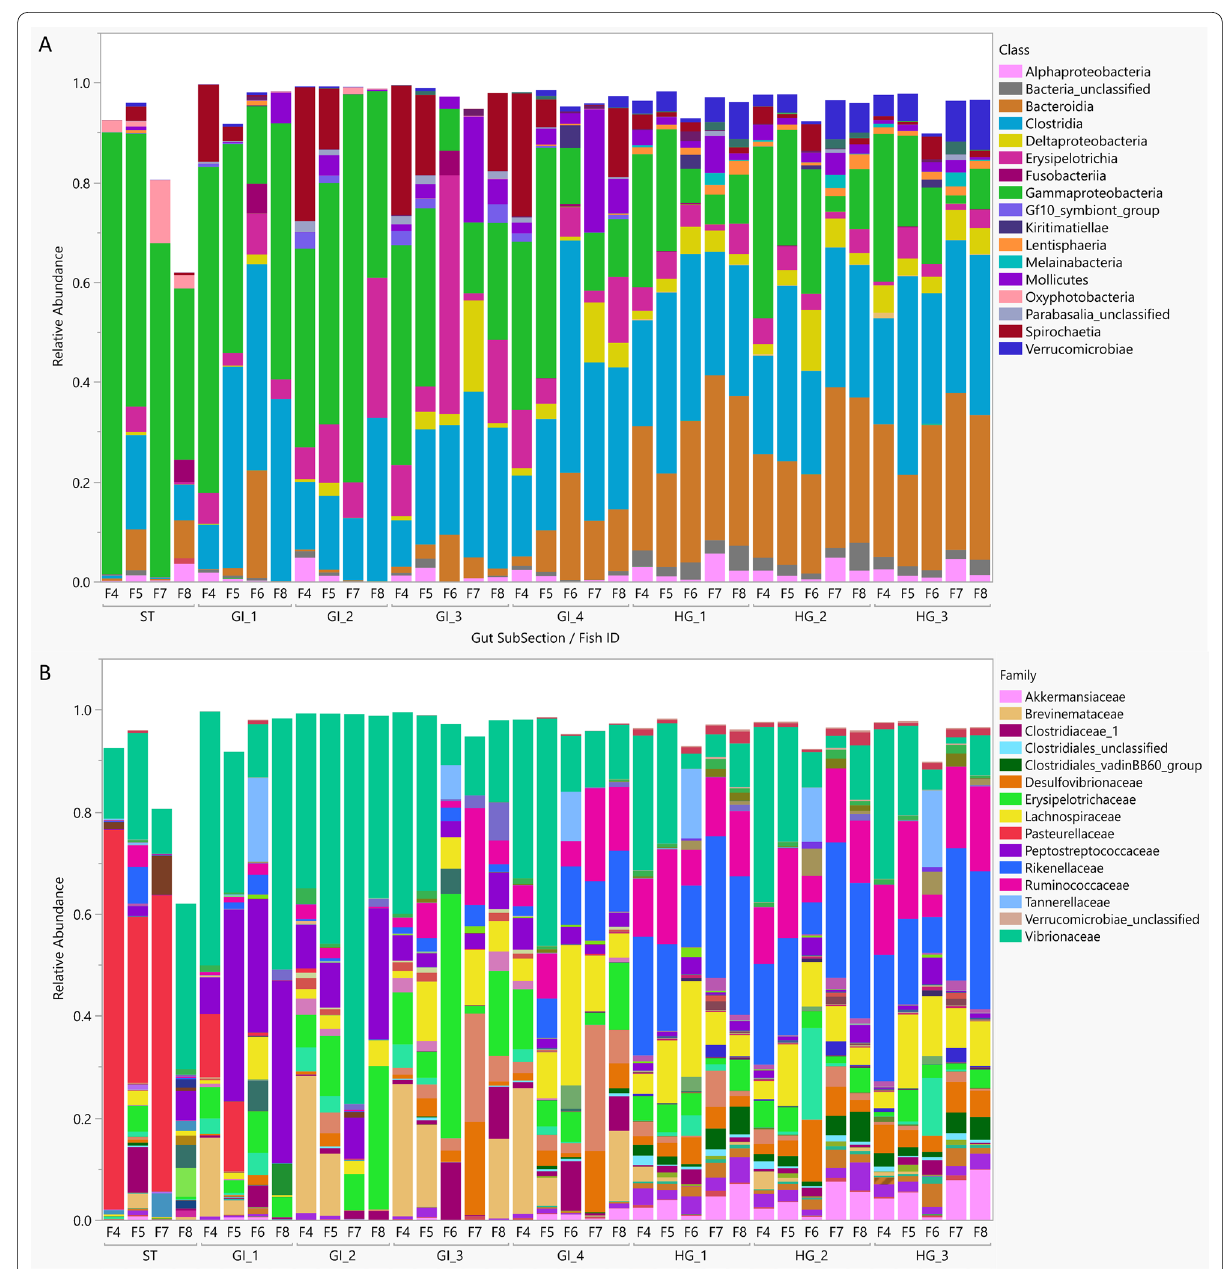
Fig. 3 Stacked bar chart of the average relative abundances of common ASVs represented at the Class level ( A ) and Family level ( B ) in the nenue gut subsections. ASVs were considered “common” if their relative abundance